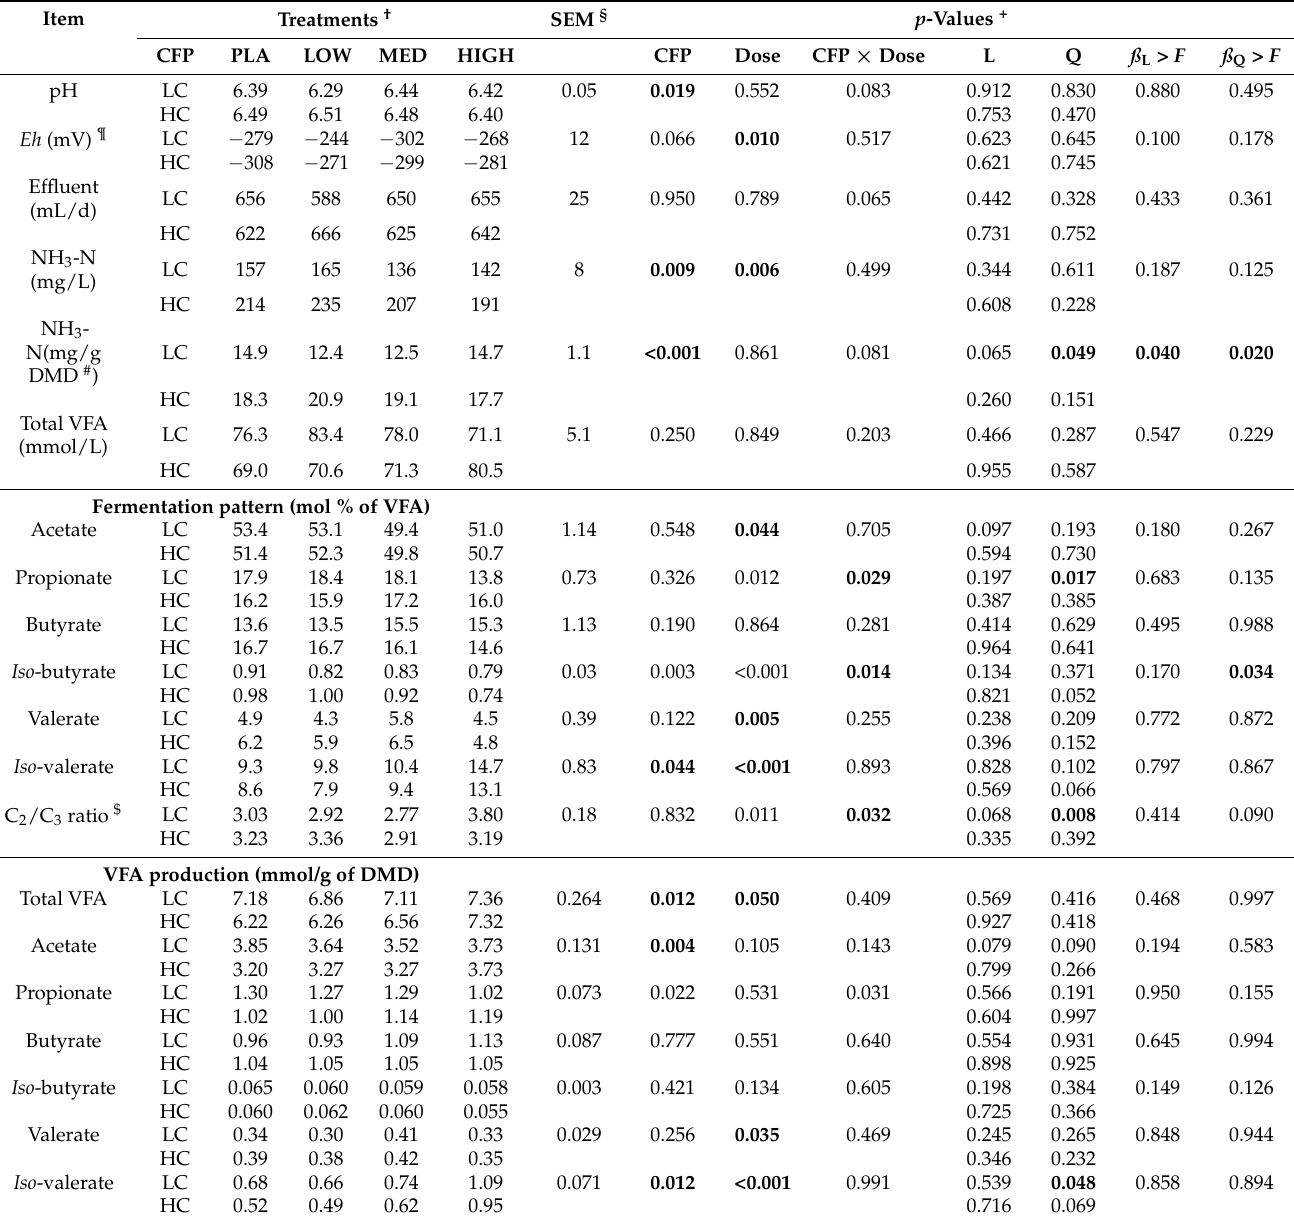
Table 4. Effects of 3-nitrooxypropanol (3-NOP) dosage levels (PLA: 0, LOW: 73, MED: 160, and HIGH: 1200 mg of 3-NOP/kg of feed DM) and low- (LC) or high- (HC) concentrate feed proportion in the diet (CFP) on fermentation characteristics and production of volatile fatty acids